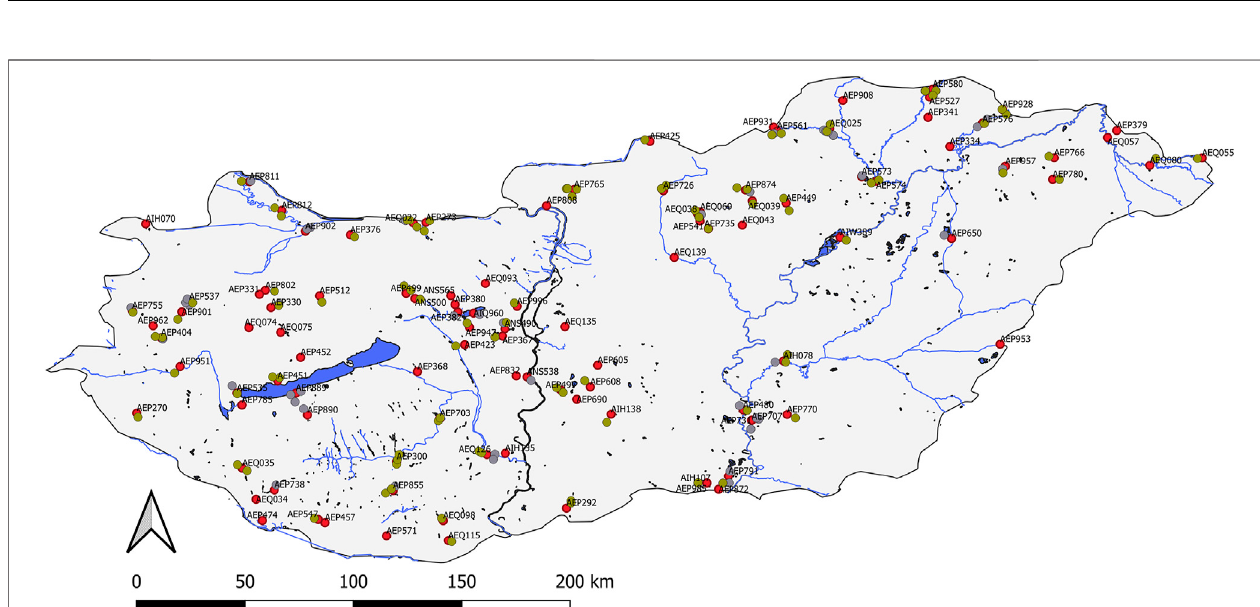
FIGURE 11 | The critical nodes of the water network and their pollution sources within the 5 km buffer area.